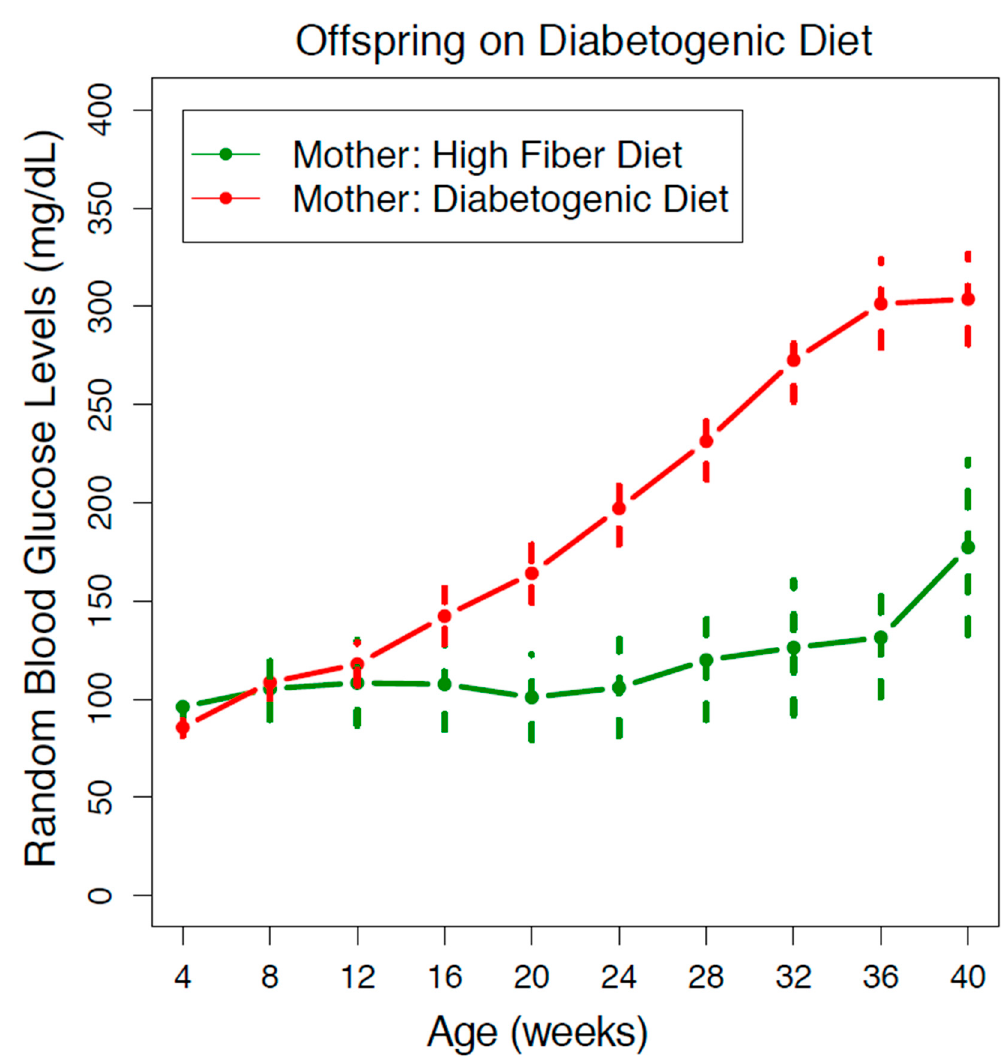
Figure 1. Maternal high-fiber diet protects offspring on diabetogenic diet. The progression of diabetes in the Nile rat offspring (both sexes) fed a diabetogenic diet is depicted as a series of random blood glucose levels from 4 to 40 weeks old. The offspring of mothers with a high-fiber diet, on average, experienced a delayed onset of diabetes and progressed more gradually to higher levels of RBG compared to offspring of mothers with a diabetogenic diet. The error bars reflect a 95% confidence interval of the data. The number of Nile rats: n = 95 (green); n = 335 (red).